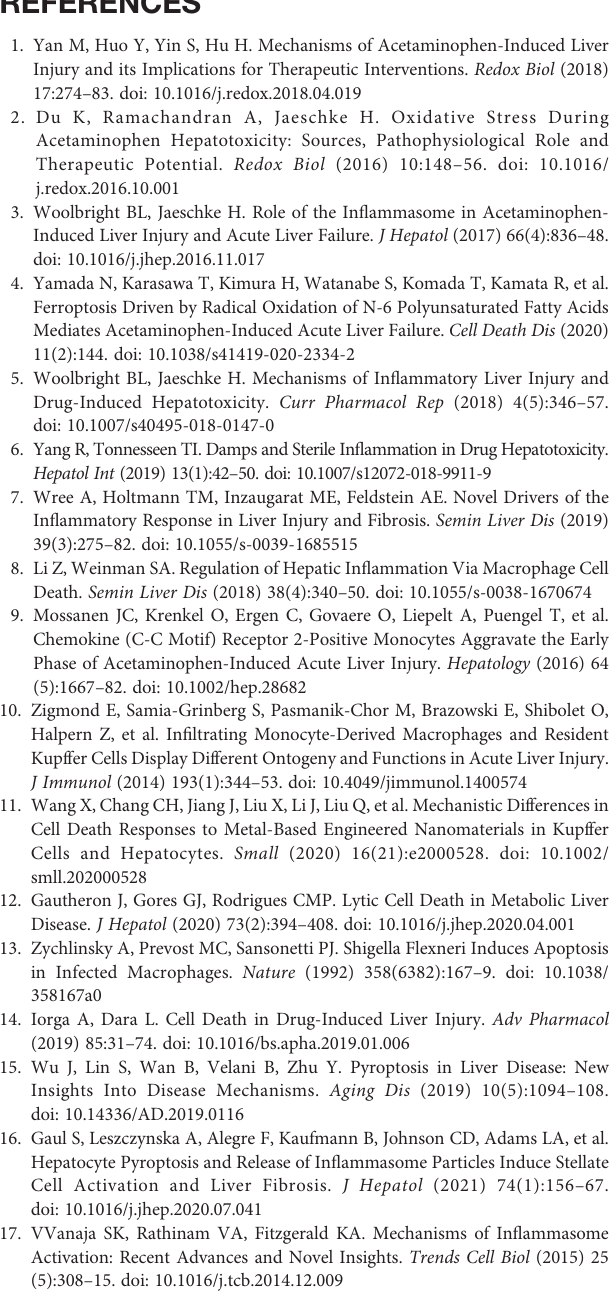
Supplementary Figure 2 | (A) NLRP3 protein levels in mice liver, n=3. (B) NLRP3 protein levels in primary KCs, n=3. (C) NLRP3 protein levels in primary hepatocytes, n=3. (D) PRX3 protein levels in primary KCs were determined, n=3. (E) PRX3 protein levels in primary hepatocytes were determined, n=3.